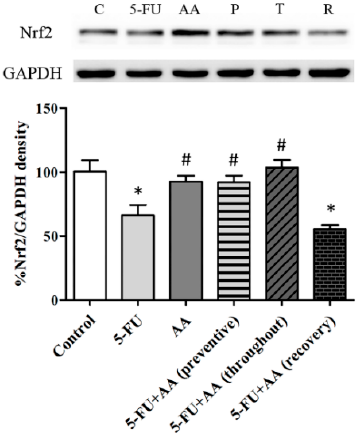
Figure 5. Mean ± SEM of nuclear factor erythroid 2 ‐ related factor 2 (Nrf2) protein in the hippocampus. * p < 0.05 and # p < 0.05 compared with the control and 5 ‐ FU groups, respectively. GAPDH (glyceraldehyde 3 ‐ phosphate dehydrogenase), C; control group, AA; asiatic acid group, 5 ‐ FU; 5 ‐ fluorouracil group, P; preventive group, T; throughout group, R; recovery group.